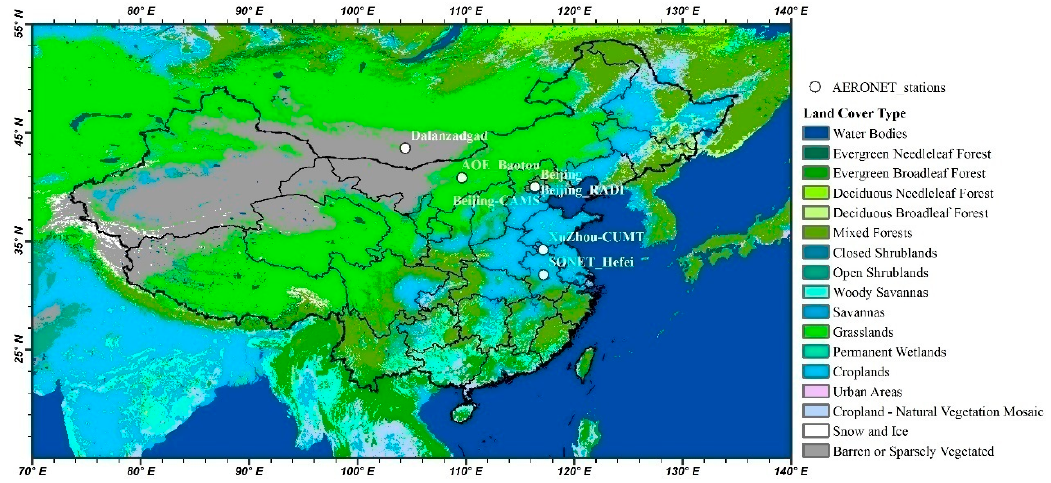
Figure 1. The land cover over China mainland region.